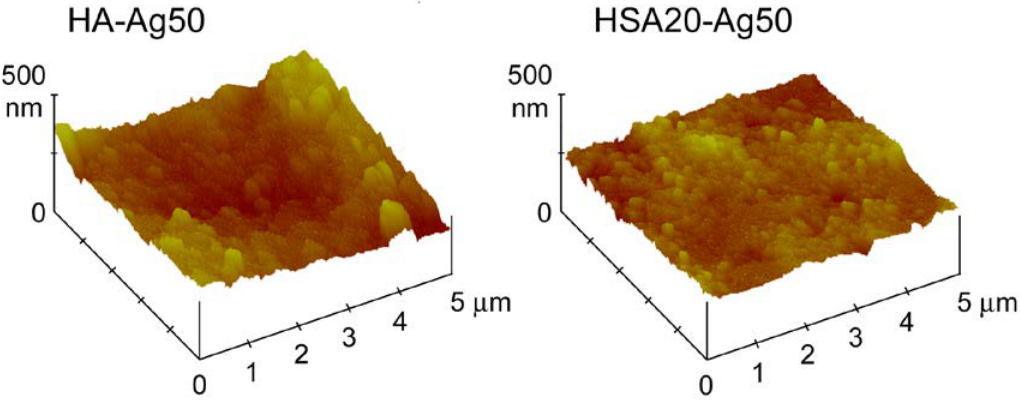
Figure 5. Atomic force microscopy images of the surfaces of disk-shaped samples obtained by pressing as-prepared HA-Ag50 and HSA20-Ag50 powders into cylindrical molds.